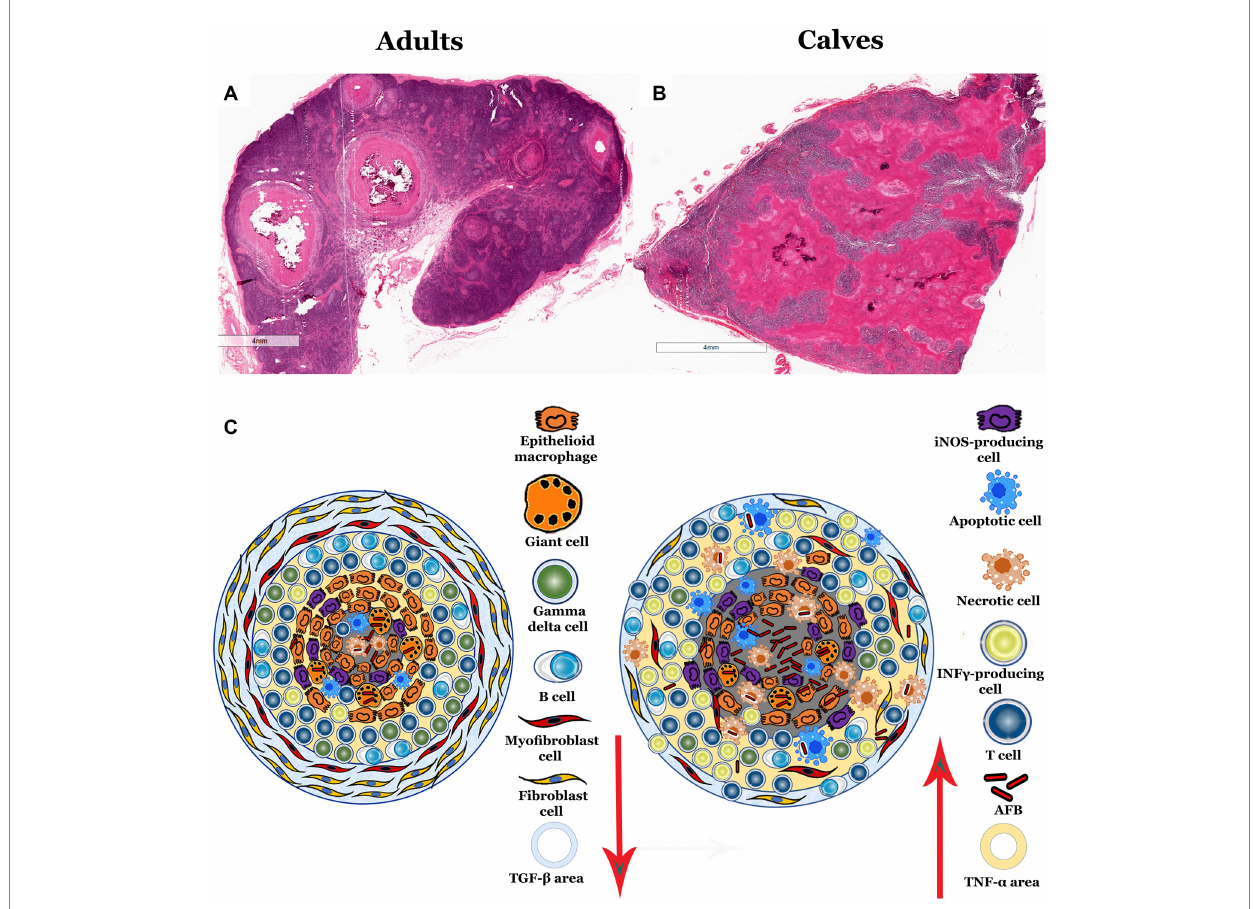
FIGURE 6 Propose schematic model of morphology and immune activity in granulomas from calves and adult cattle naturally infected with Mycobacterium bovis . (A,B) , 5× H&E staining of lymph node sections with infection-induced granulomas. (A) Adult bovine lymph node with different stage II and IV granulomas found in the lymph node medulla and cortex with the classic structure. (B) Calf lymph node, showing granulomatous lesions with a large amount of necrosis and absence of the connective tissue capsule. (C) Diagram summarizing the differences identified in granulomas, showing